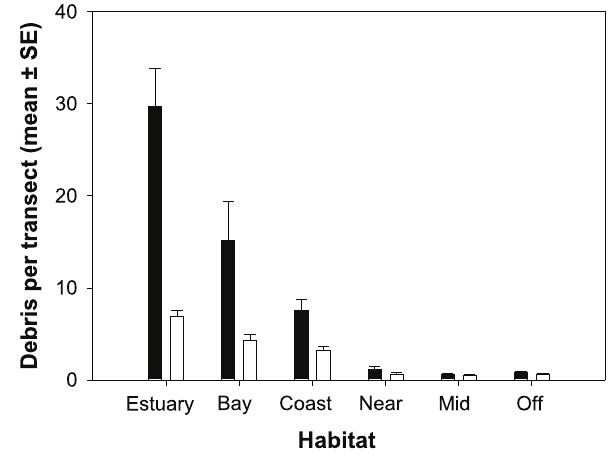
Figure 2. Mean ( ± SE) debris loads (filled bars) and diversity (unfilled bars) of debris items per transect averaged over all sites within each habitat category.